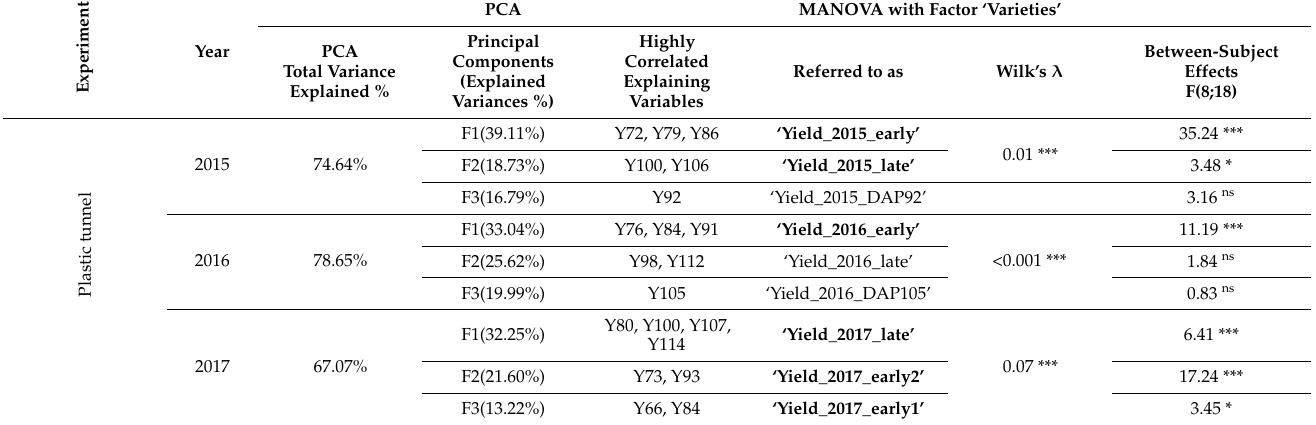
Table 4. The results of the principal component analysis for the yield of the plastic tunnel experiment: the explained variances of the PCs as well as the total explained variance rates; the original variables that are highly correlated with the PCs (with high loadings) and the names that refer to the PCs later on; Wilk’s λ (unexplained variance rate) values (overall MANOVA results) and the follow-up ANOVA tests (between-subject effects) with F values and their significances.